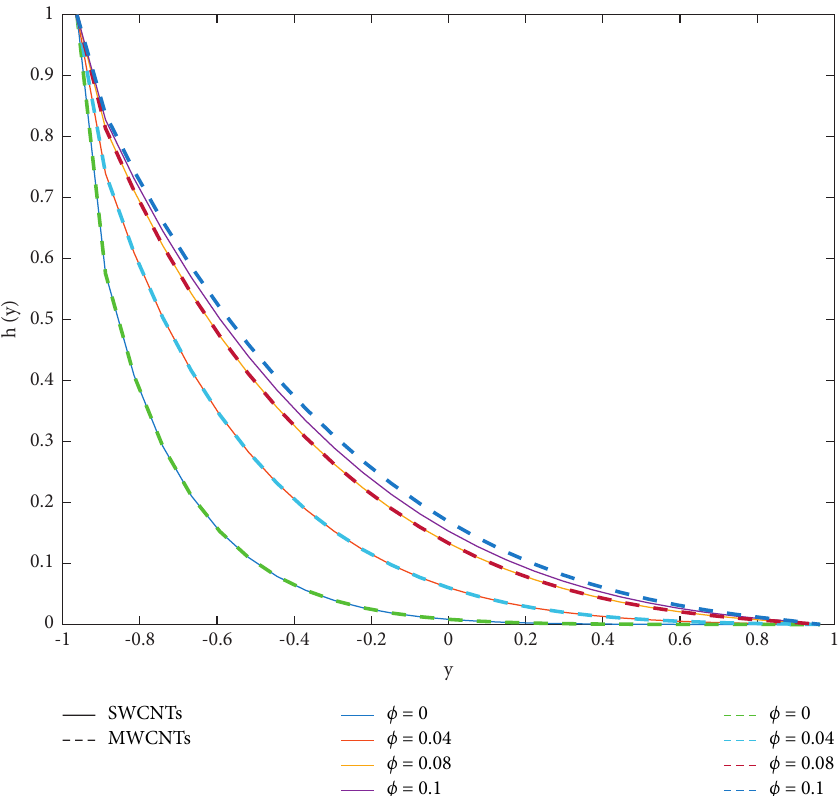
Figure 10: Impact on temperature profile h ( y ) via S2HWs for the parameters A ∗ � − 0 . 2 ,R � 2 . 5 , α � − 1 . 5 , Pr � 6 . 2.